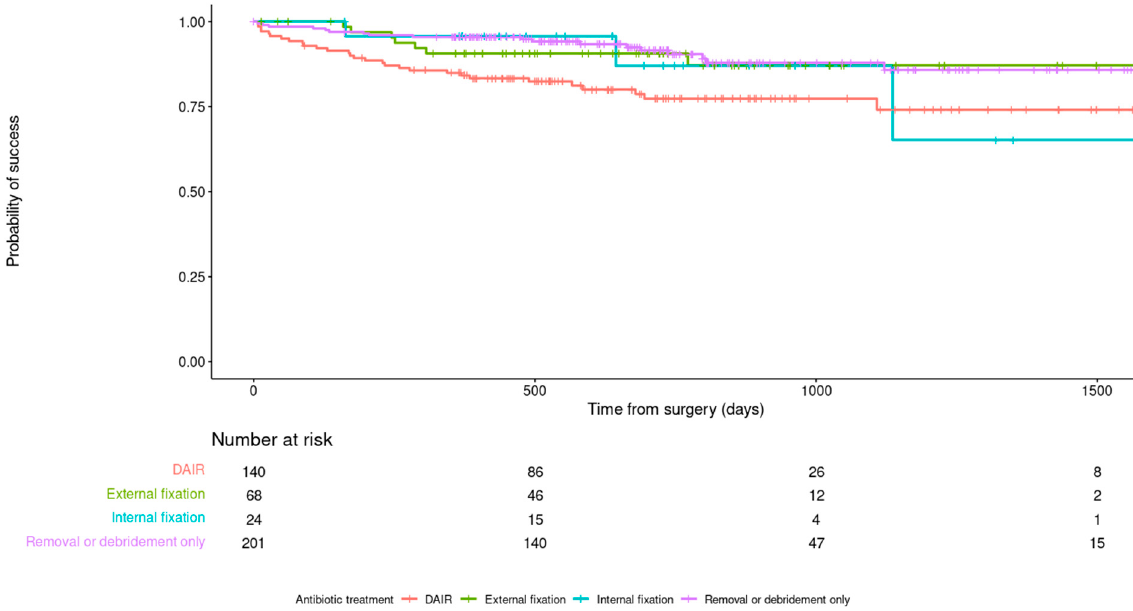
Figure 2. Kaplan–Meier survivorship curve demonstrating the relationship between method of fixation after debridement and primary outcome.